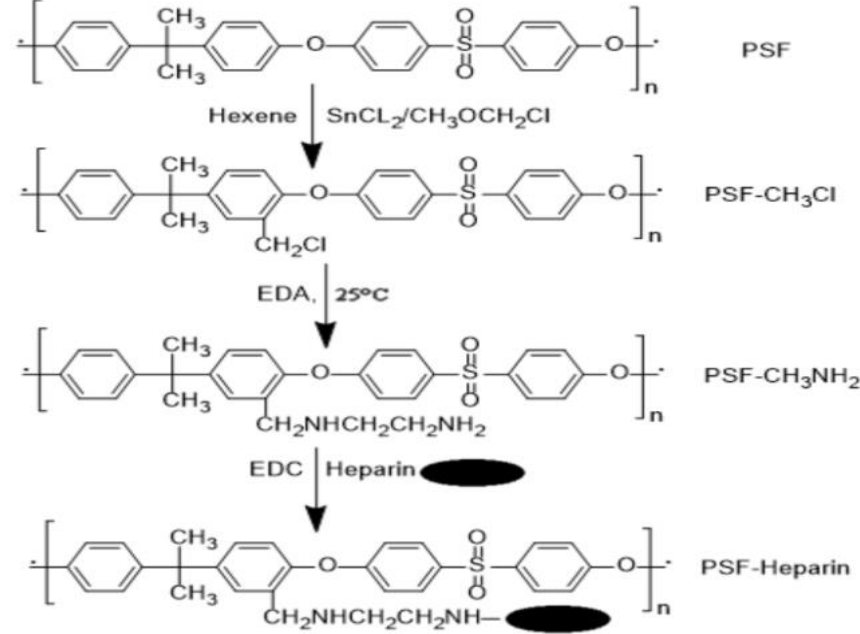
Figure 12. Immobilization of heparin on polysulfone membrane.